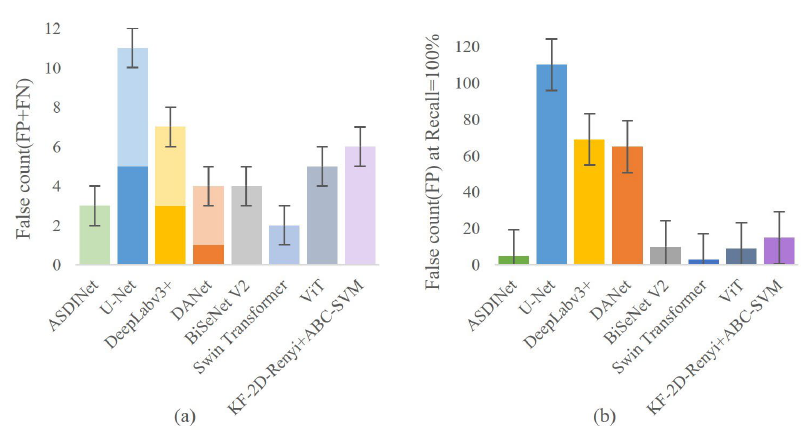
Figure 9. Model performance evaluation (the dark color is FP, and the light color is FN). Among them, ( a ) represents the error count under normal conditions, and ( b ) represents the error count when Recall = 100%.